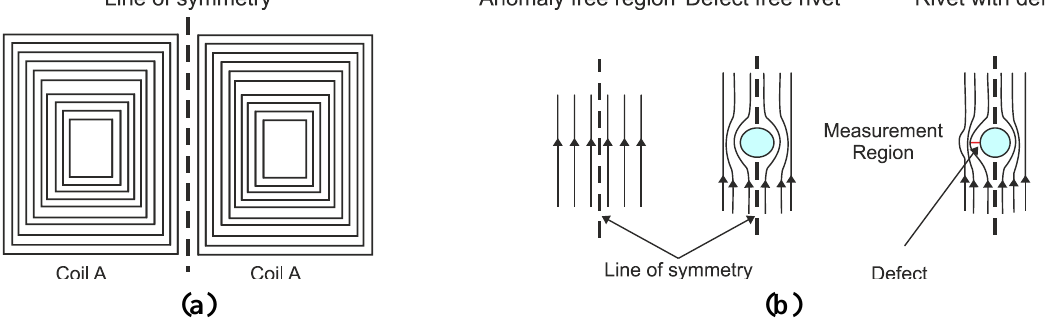
Figure 15. (a) Schematic of the multi-line coil for inducing linear eddy currents (adapted from [43]). (b) Induced eddy current flow in the absence and presence of rivet and cracked rivet (adapted from